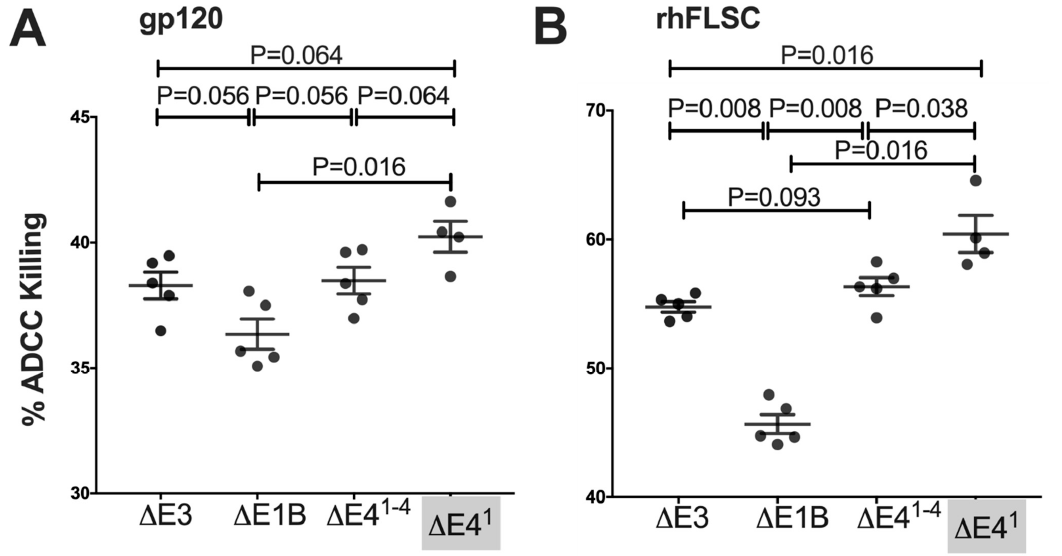
Figure 8. ADCC activity in Ad vector-immunized rhesus macaques. ADCC activity was measured at wk 38 (2 wks post second protein boost) using plasma from immunized rhesus macaques. Antibodies were evaluated against HIV-1Bal gp120 and rhFLSC-coated EGFP-CEM-NKr-CCR5-SNAP cells